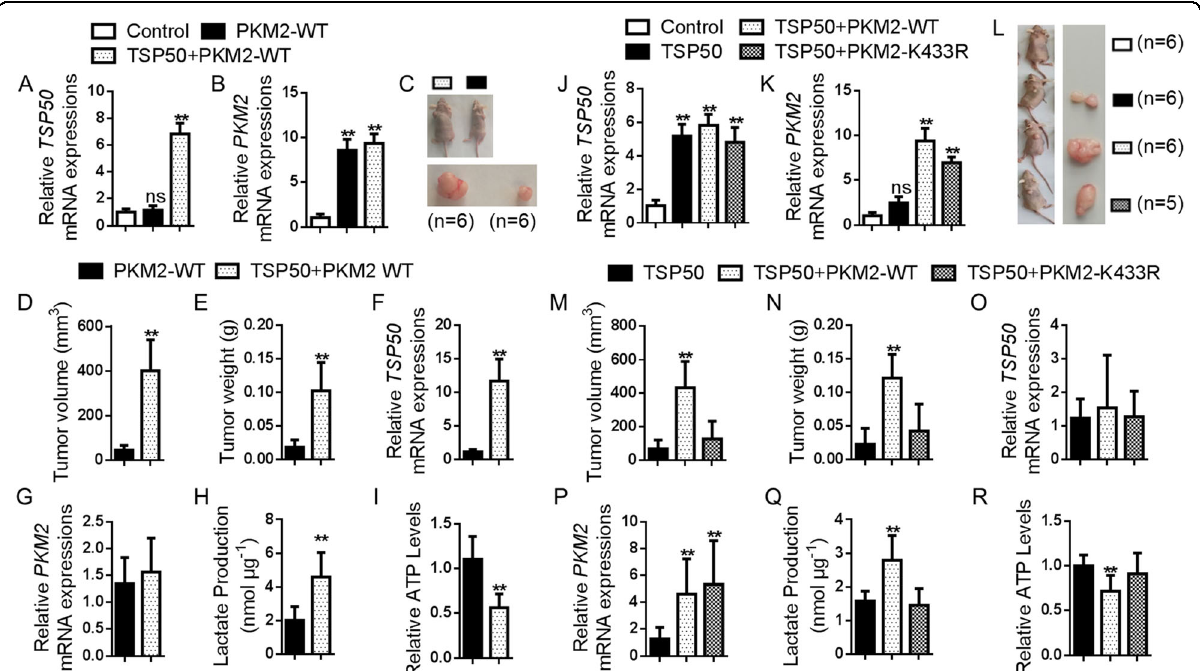
Fig. 8 PKM2 K433 acetylation is required for TSP50-induced tumor growth. A – C Photography of xenograft tumor-bearing mice injected with different cell lines transfected. D , E Tumor volume and tumor weight for each group. F – I Expression of TSP50 and PKM2, lactate production and ATP levels were detected in tumor. J – L Photography of xenograft tumor-bearing mice injected with different cell lines transfected. M , N Tumor volume and tumor weight for each group. O – R Expression of TSP50 and PKM2, lactate production and ATP levels were detected in tumor. n = 6 in each group. All aerobic glycolysis values were normalized to protein levels. N = 3 biologically independent replicates. t -Test or one-way ANOVA statistical analysis was used. Data were presented as means ± s.d. *P < 0.05, **P < 0.01. ns, no signi fi